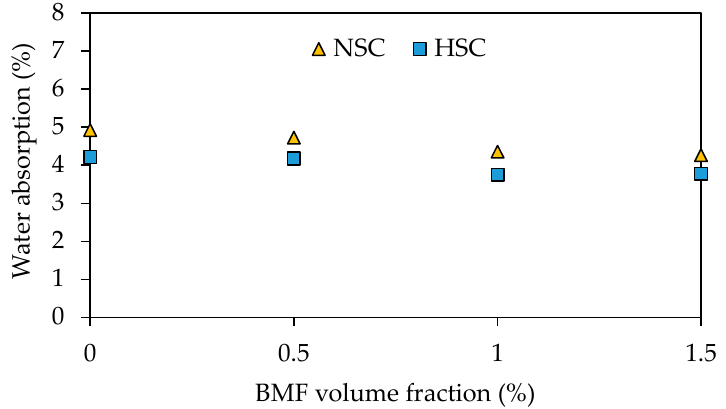
( d ) Figure 14. Failure mode of NSC and HSC prismatic specimens: ( a ) NSC-BMF0.0; ( b ) NSC-BMF1.5; ( c ) HSC-BMF0.0; ( d ) HSC-BMF1.5. 4.3. Durability Properties 4.3.1. Water Absorption Results of the water absorption are depicted in Figure 15 and summarized in Table 9. The water absorption values of NSC and HSC benchmark specimens were 4.93 and 4.22%, respectively. The water absorption tended to decrease with an increase in the BMF